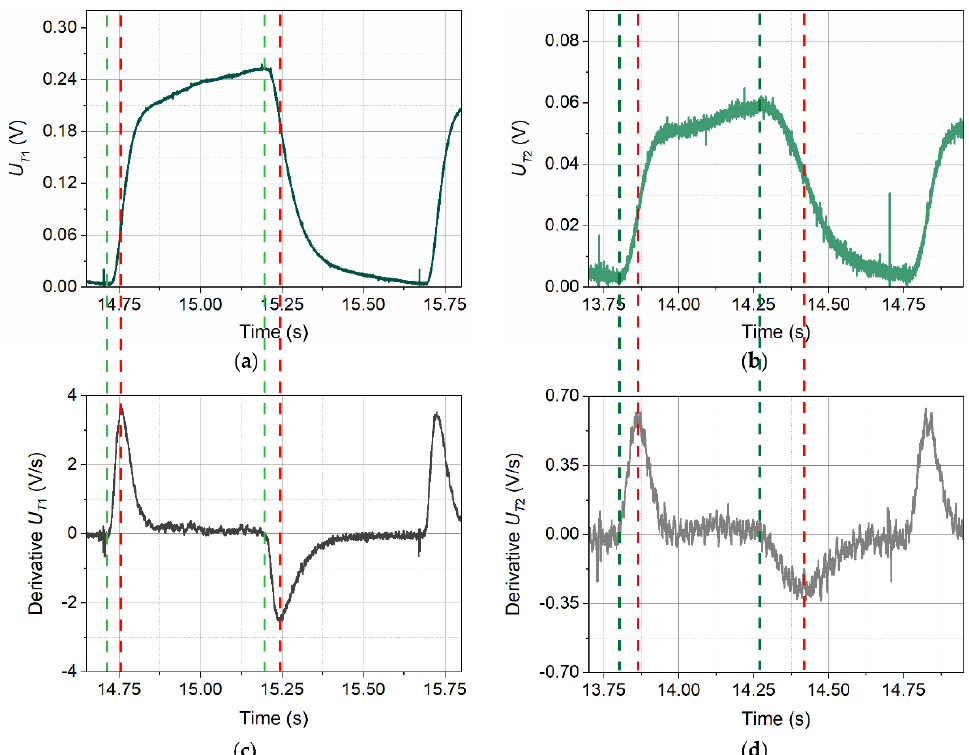
Figure 10. Pulses recorded by detector T1 ( a ) and T2 ( b ) at the thermal wave frequency f = 1.00 Hz, and the inflow velocity v ∞ = 0.065 m/s and their derivatives, ( c , d ), respectively. Dashed lines connect characteristic points from the corresponding graphs.